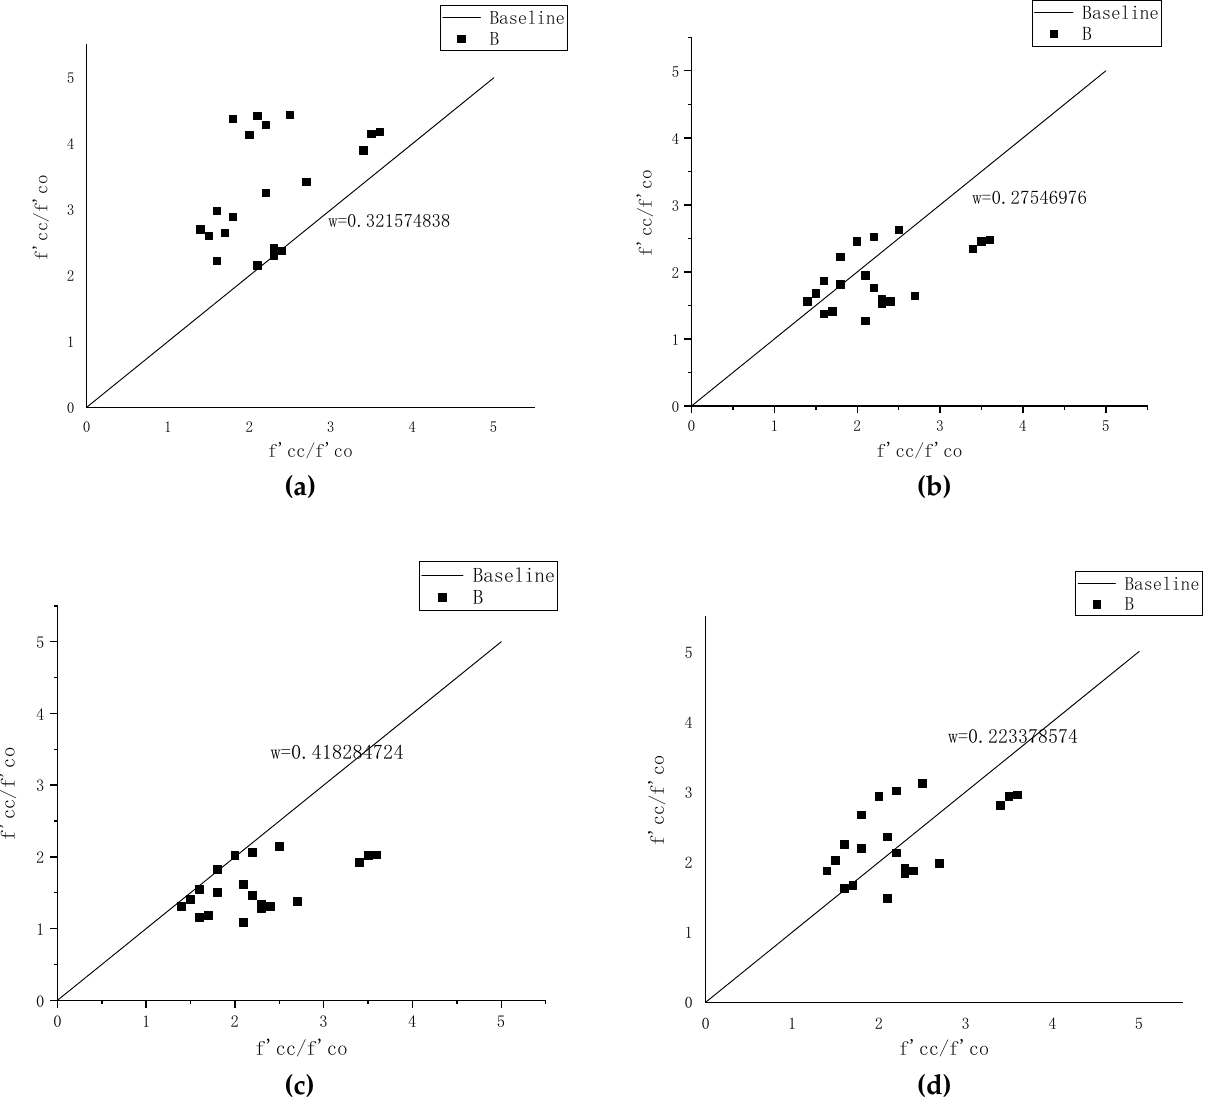
Figure 14. Error analysis of ultimate stress of FRP-confined concrete: (a) Karbhari & Gao model error analysis; (b) Toutanji model error analysis; (c) Lam & Teng model error analysis; (d) Jiang & Teng model error